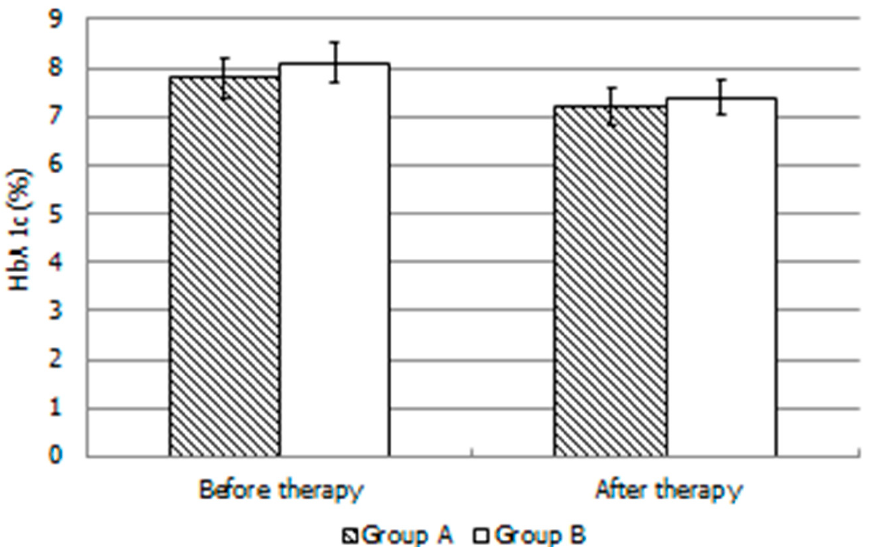
Figure 1. Glycated hemoglobin levels in each group of patients with type 1 diabetes mellitus before and after administration of L-Acetyl-Carnitine or L-Acetyl-Carnitine plus L-Carnitine. Type 1 diabetes mellitus (DM1) (a) L ‐ acetylcarnitine (LAC) 500 mg tablets every 8 hours every day for 4 months; DM (b) LAC 500 mg tablets every 8 hours and LC 2 g oral solution only once a day for 4 months. Values are shown as mean ± SD.